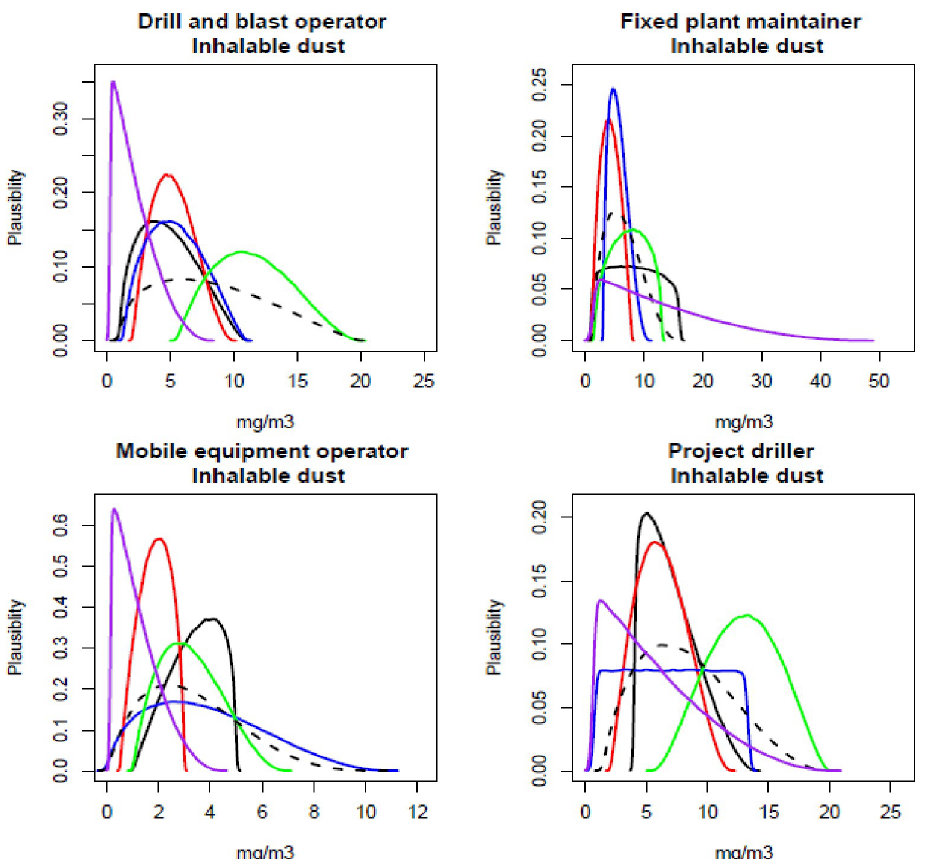
Fig 1. Expert estimates and measured data of inhalable dust concentrations. Each curve depicts the experts support (probability density) or measured data encoded into a scaled Beta distribution. Experts are denoted in the colours blue, red, black and green; combined experts are the dashed line. Measured data is presented as